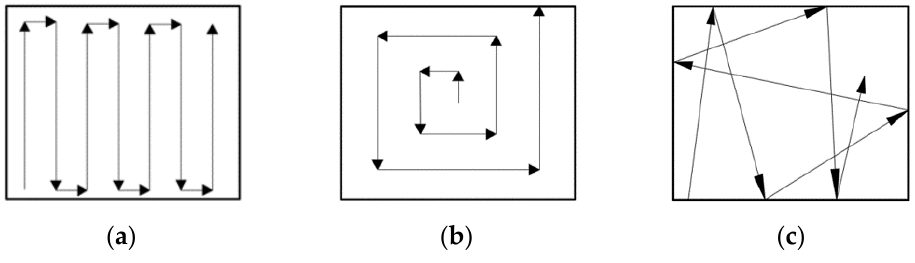
Figure 4. Three common coverage patterns. ( a ) Back-and-forth; ( b ) spiral; ( c ) random. The spiral pattern is only suitable for convex polygonal areas, while the random the BF pattern for a port area.